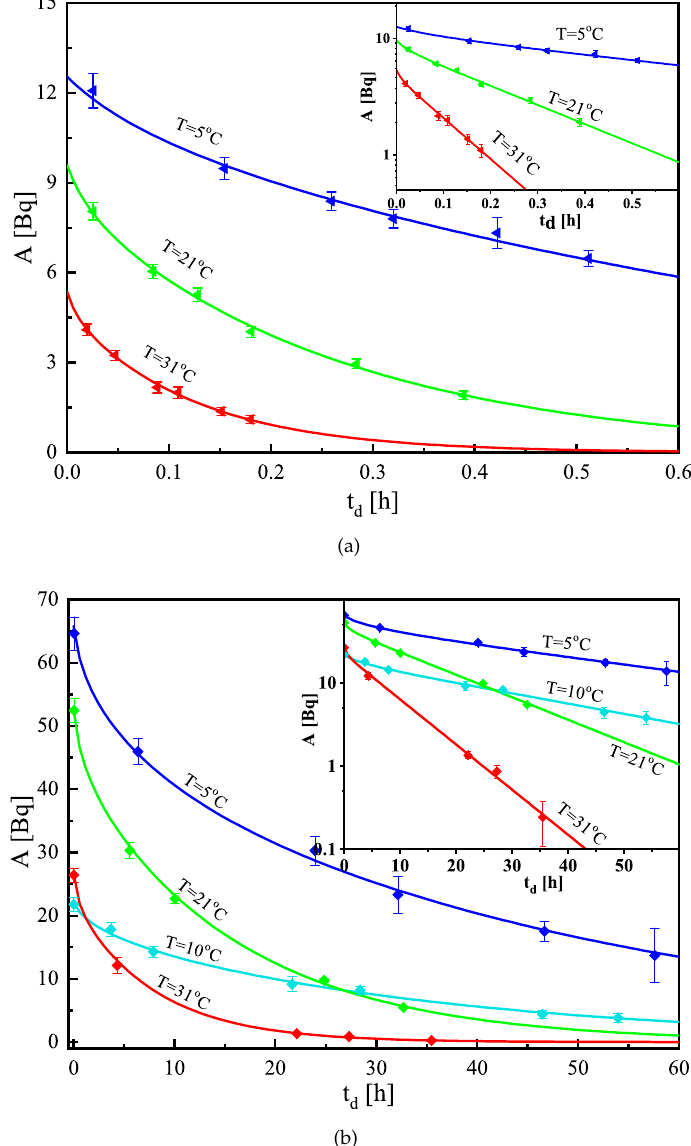
Figure 4. Experimental data (points) and theoretical curve fits (solid lines) of the desorption follow-up of radon from ( a ) High-density polyethylene and ( b ) Makrofol DE foils for the estimation of the partition coefficient and diffusion length at different temperatures. To fit the same scale, the activity data of Makrofol DE at 10 ◦ C are multiplied by 10, as the radon activity concentration in this experiment was one order of magnitude lower than in the other three. The uncertainties are at the level of 1 σ . The embedded smaller graph presents the same data in semi-log scale—it is seen that, in the early desorption the dependences are nonlinear in semi-log scale, i.e., they are sums of several exponents rather than single